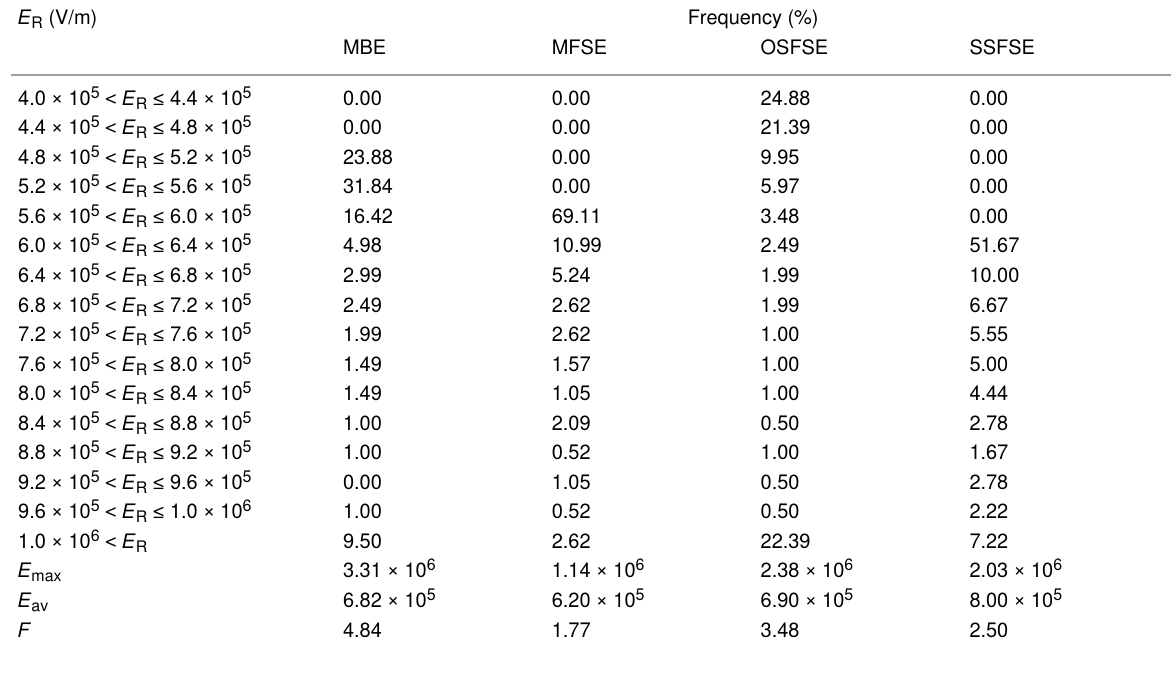
Table 3: Detailed distributions of the electric field intensity along the radial axis (0–20 mm) of the four self-made FSE devices. E R